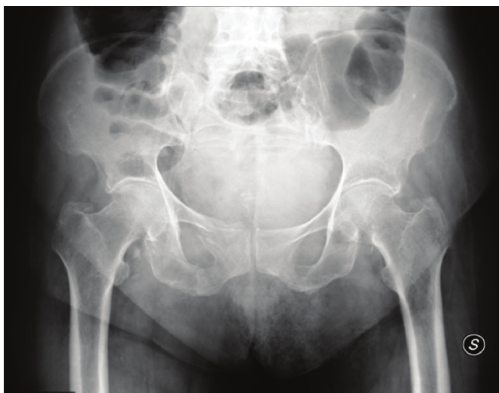
Figure1:Anteroposteriorpelvicradiographrevealingrightsuperior and inferior pubic rami fractures.